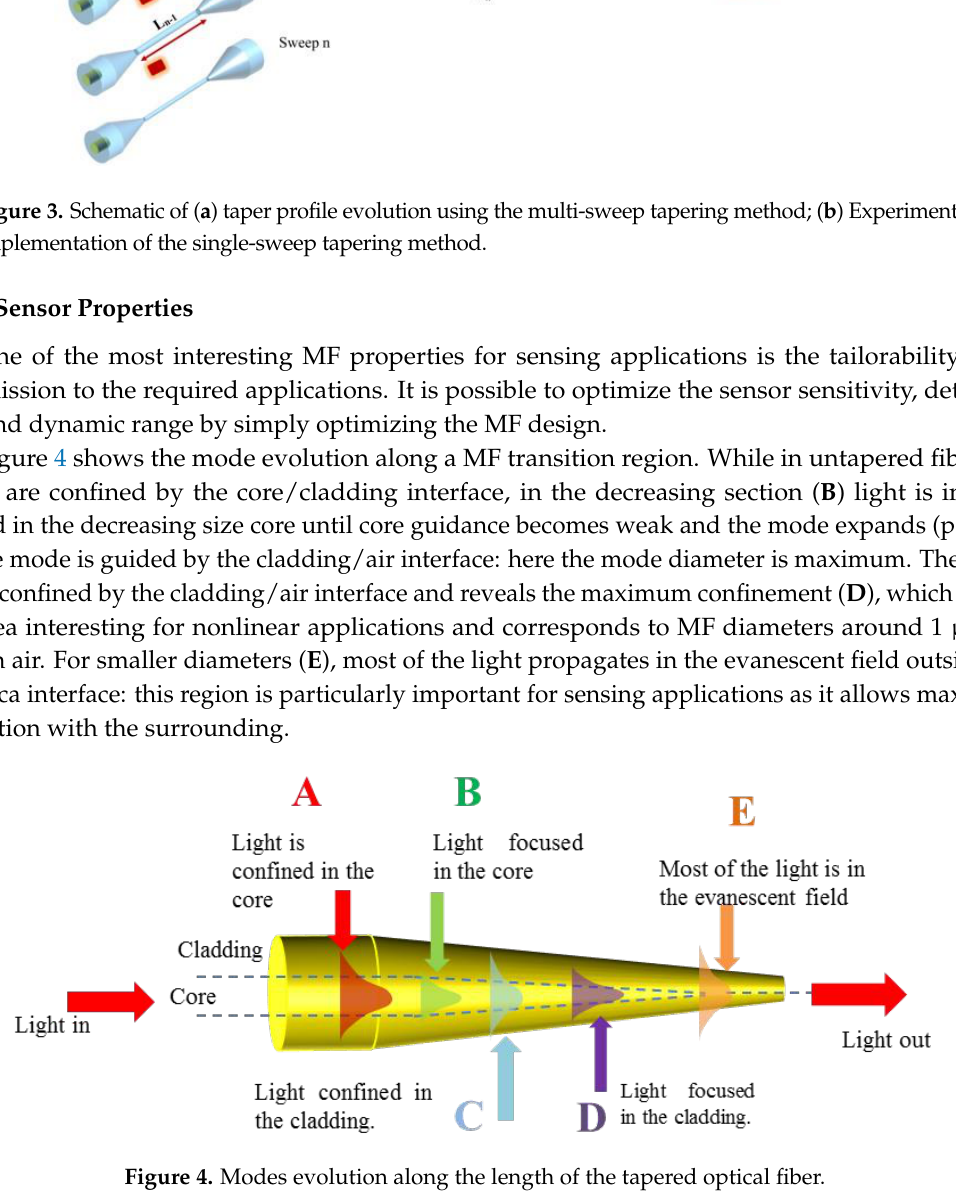
Figure 4. Modes evolution along the length of the tapered optical fiber.